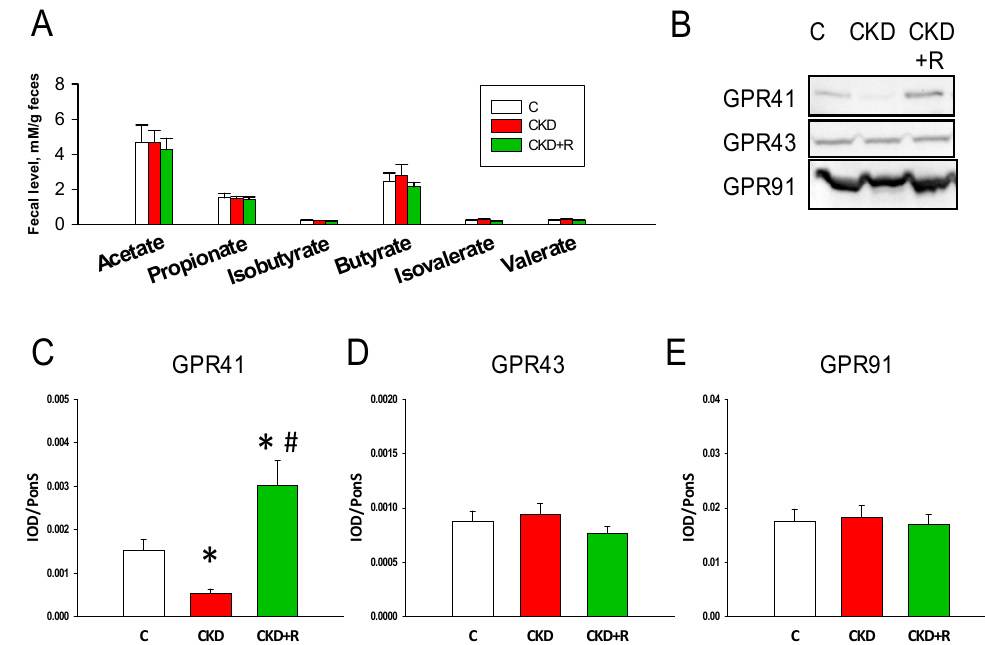
Figure 7. (A) Effects of maternal chronic kidney disease (CKD) and resveratrol (R) treatment on fecal levels of short chain fatty acids (SCFAs) in male offspring at 12 weeks of age. (B) Representative Western blots and relative abundance of (C) GPR41 (45 kDa), (D) GPR43 (47 kDa), and (E) GPR91 (38 kDa) in male offspring’s kidneys at 12 weeks of age. N = 7–8/group; * p < 0.05 vs. C; # p < 0.05 vs. CKD.